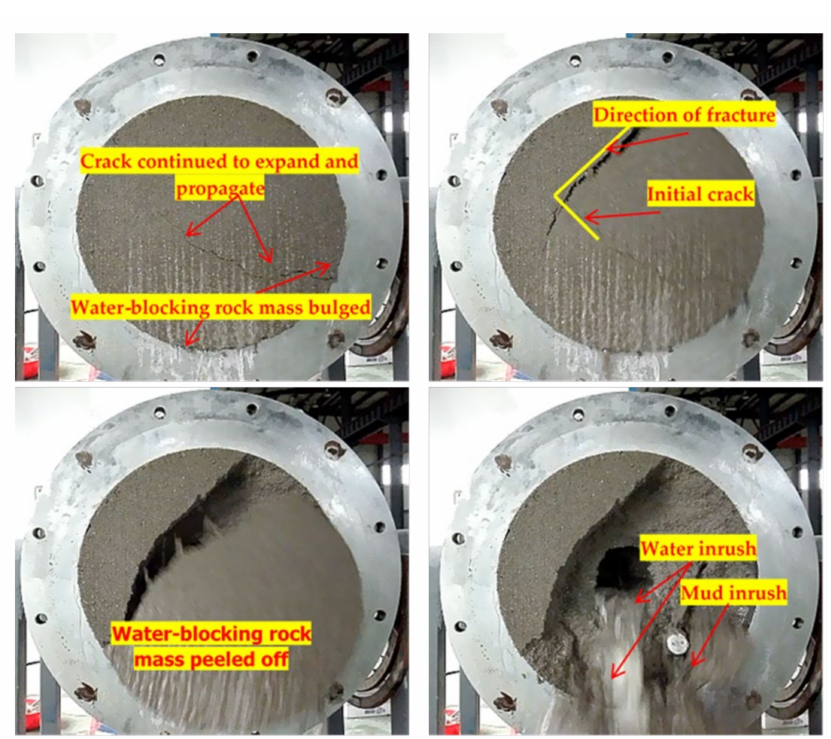
Figure 2. Test process and phenomena of water inrush 3. development of test